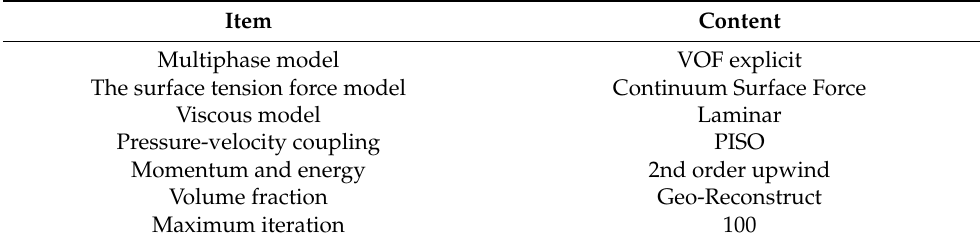
Figure 1. Illustration of the computation model with boundary conditions indicated. Table 1. Numerical simulation settings.